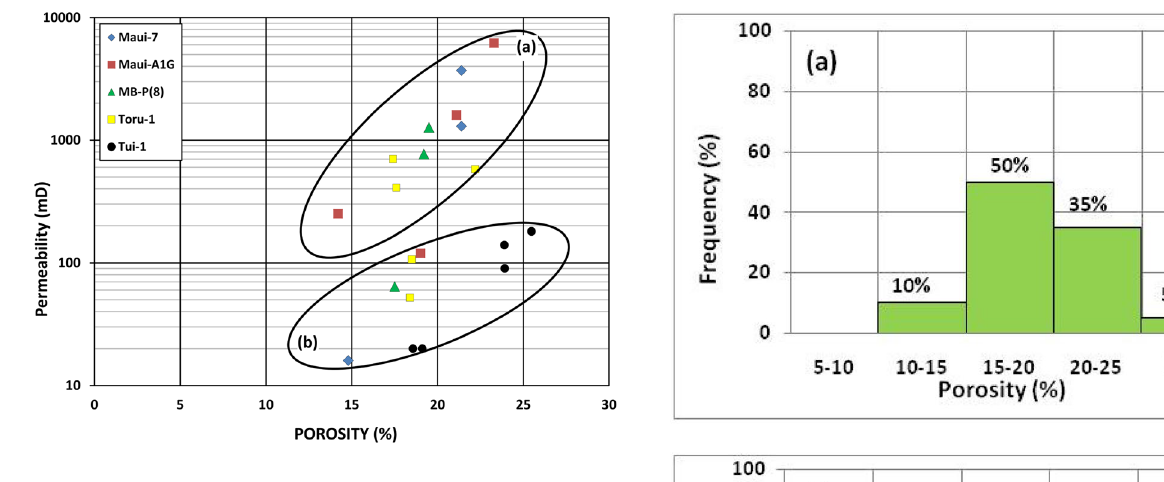
Fig. 3 A cross-plot of porosity–permeability relationship for the Kaimiro Formation in the studied wells